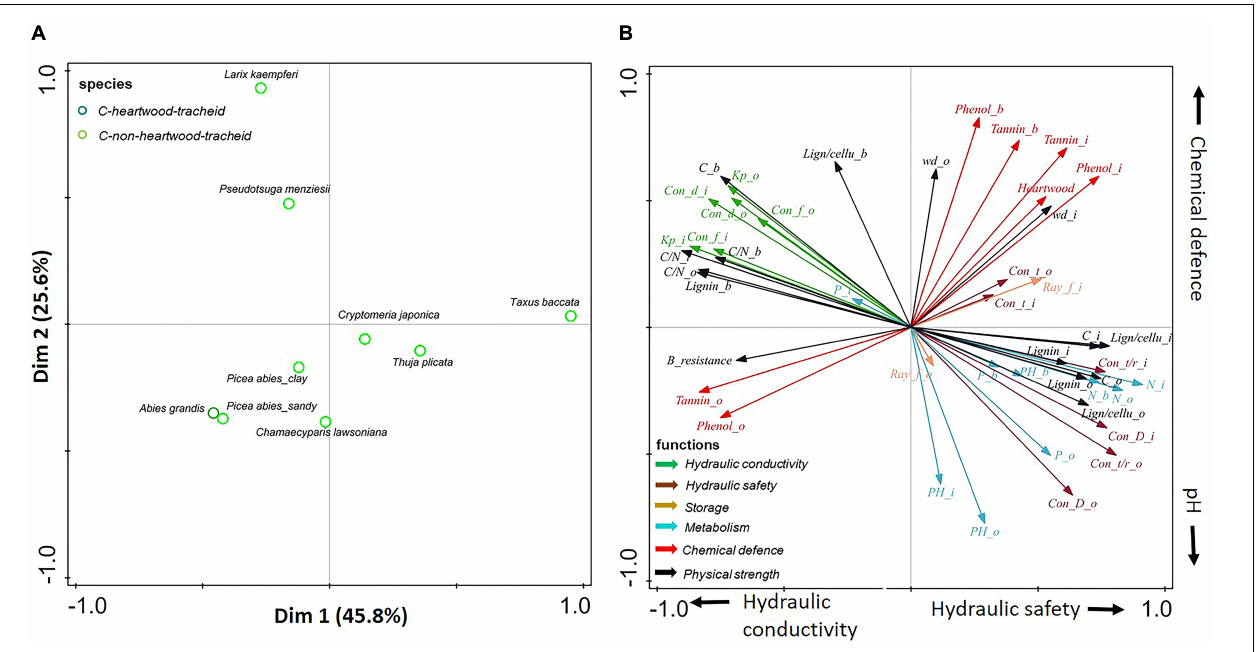
FIGURE 5 | (A,B) Principal-component analysis based on stem traits assessed in three compartments (inner wood, outer wood, and bark) for eight gymnosperms. Dark green circles show gymnosperms with heartwood; light green circles show gymnosperms without heartwood. The traits (indicated with arrows) are grouped according to six functions: hydraulic conductivity (in green), hydraulic safety (in dark brown), storage (in light brown), metabolism (in blue), chemical defense (in red), and physical strength (in black). For trait abbreviations, see Supplementary Table 2